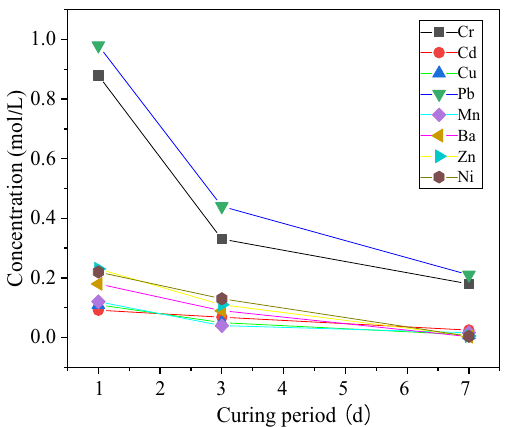
Figure 7. Influence of curing age on leaching of heavy metal from